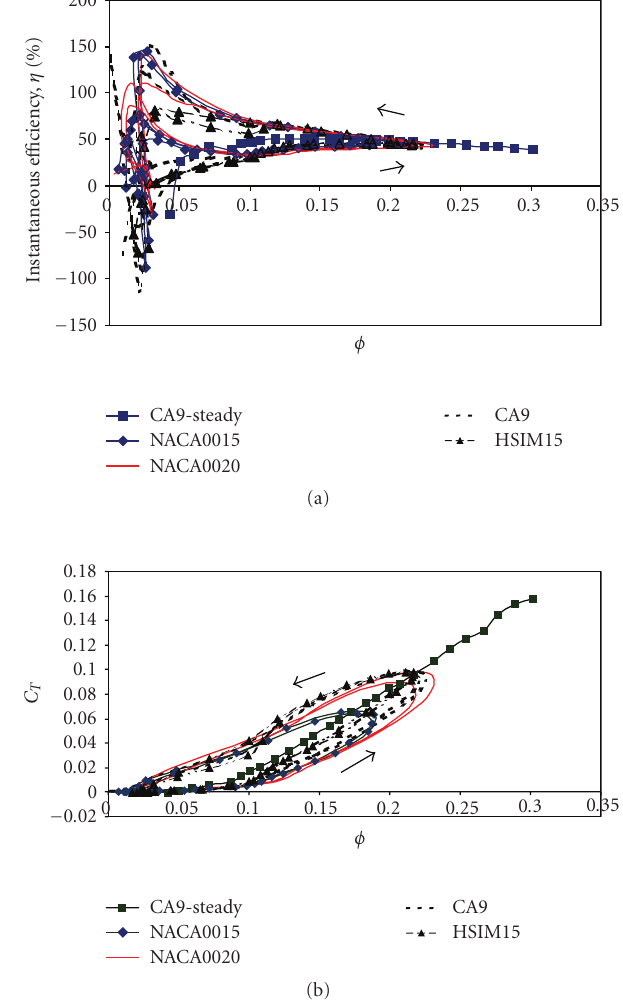
Figure 9: Variations of instantaneous e ffi ciency and torque coe ffi - cient for di ff erent blade profile at 1 /κω ∗ = 0 . 2 ( σ = 0.64): (a) e ffi - ciency, (b) torque coe ffi